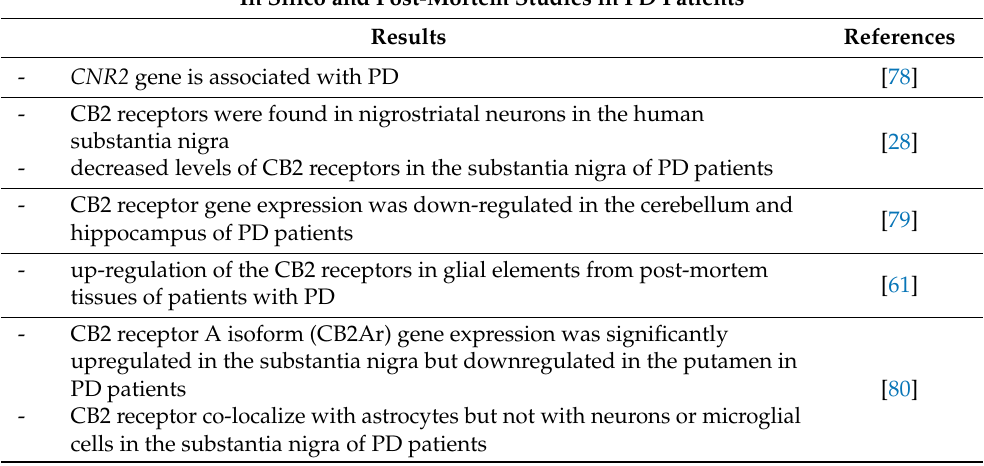
Table 1. Schematic overview of the most important findings from the in silico and post-mortem studies investigating the CB2 receptors in PD patients. In Silico and Post-Mortem Studies in PD Patients